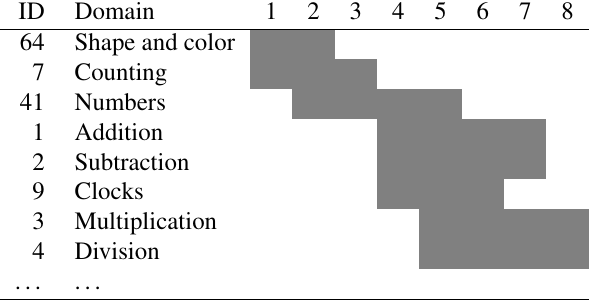
Table 1. A selection of the Math Garden domain IDs mapped to the Dutch national curriculum domains for grades